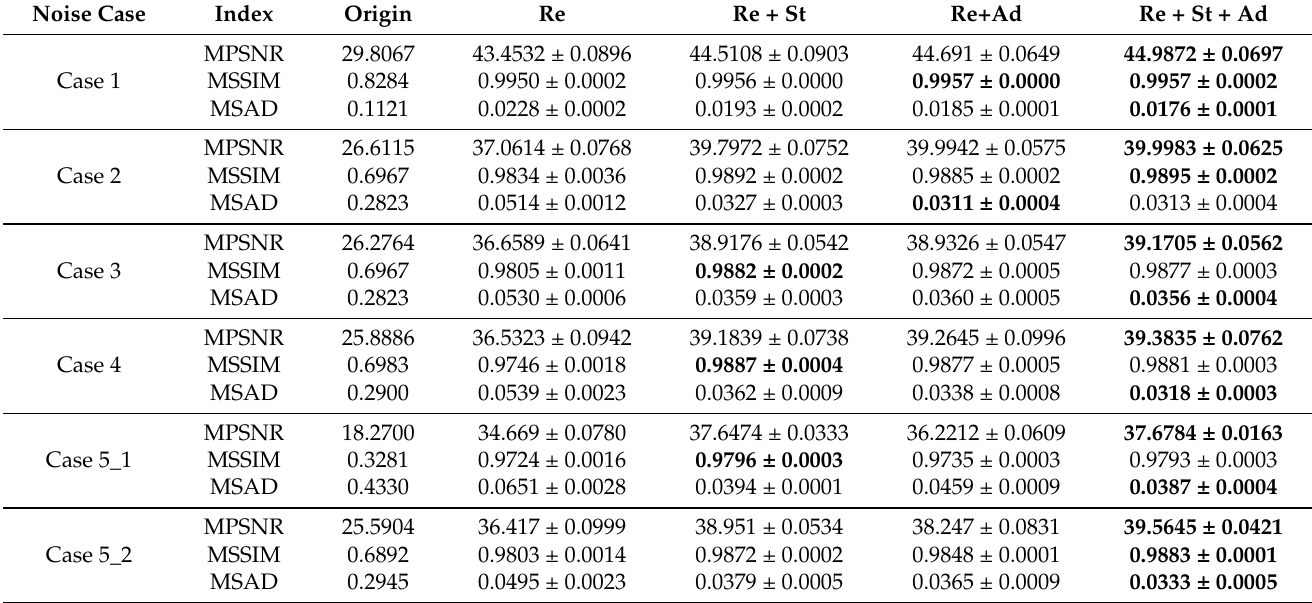
Table 3. Quantitative evaluation of the ablation experiment on the SFD dataset: loss functions. Re means the reconstruction loss; St means the structural loss; and Ad means the adversarial